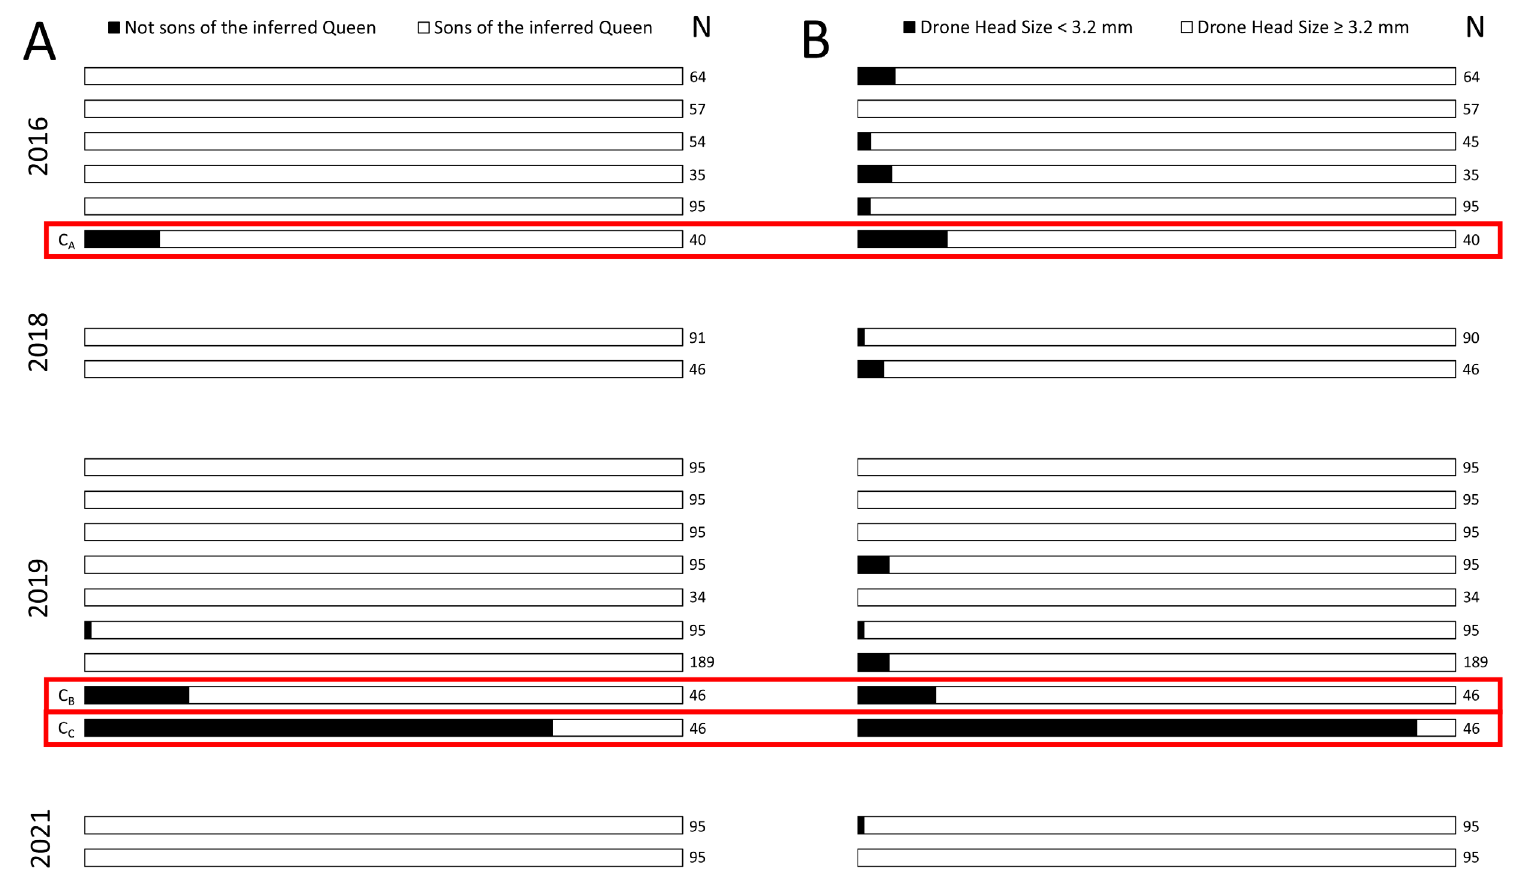
Figure 1. Each bar represents a colony used in this study, with the three colonies with high proportions of “non-queen” drones indicated in red and labelled as C A , C B , and C C . ( A ): The proportion of drones that do not match the genotype of the queen. In most colonies, all, or almost all, drones match the genotype of the queen, except for C A , C B , and C C wherein 12.5%, 17.4%, and 78.3% of drones do not match the queen’s genotype. ( B ): The proportion of drones with very small head sizes (<3.2 mm) in each colony. Drones with head sizes in this category have typically been reared in worker-cells and not drone cells and therefore are indicative of colonies with laying workers.